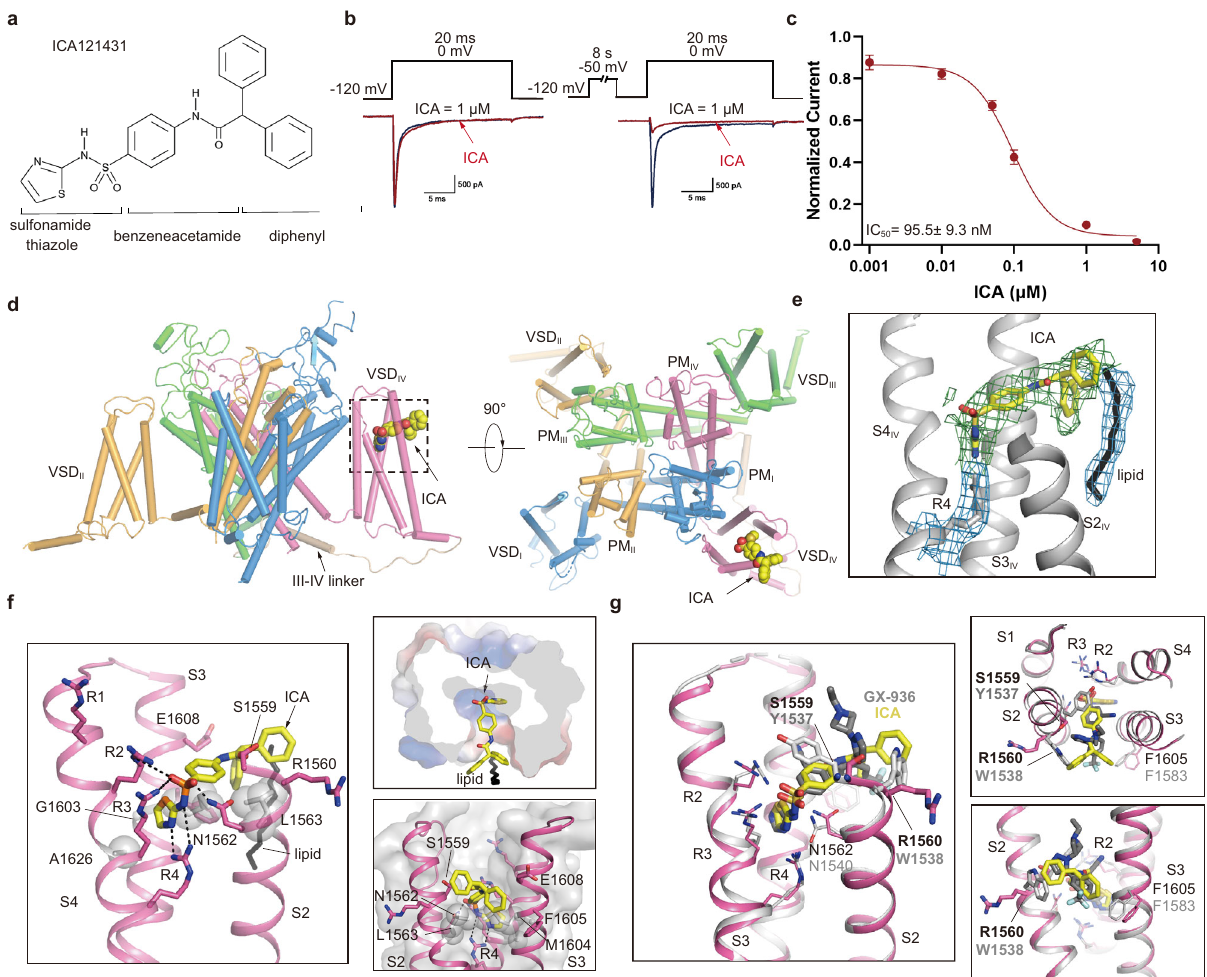
Fig. 4 Inhibition of Na V 1.3 by ICA and the binding site for ICA. a The chemical structure of ICA. b ICA preferentially inhibits Na V 1.3 at inactivated state. Current traces were recorded on Na V 1.3-transfected HEK293T cells, showing the effect of 1 μ M ICA (red line) on Na V 1.3 using a resting-state inhibition protocol containing a 20-ms voltage step to 0 mV from holding potential (HP) at − 120 mV (left panel), or an inactivated-state inhibition protocol composed of an 8-sec pre-pulse conditioning step at − 50 mV to inactivate roughly half channels and back to − 120 mV for 10-ms followed by a 20-ms test pulse at 0 mV from HP at − 120 mV (right panel). Similar data were acquired from 6 cells for each protocol. c Dose-response of ICA on human Na V 1.3 using the inactivated-state inhibition protocol as described in panel ( b ). The Boltzmann distribution was fi tted to each data of the normalized remaining peak current under different ICA concentrations, to yield IC 50 at 95.5 ± 9.3 nM. Data are mean + / − SEM acquired from 3 – 6 cells. d ICA binding site in Na V 1.3. The complex structure of Na V 1.3 is shown in side view (left panel) and top-down view (right panel), with ICA shown in a sphere model. The black dashed square indicates the area to be shown in panel ( f ). e Cryo-EM densities at 2.4 σ for ICA (green mesh), R4 and a potential lipid molecule (blue mesh). f Detailed binding site for ICA inside the VSD IV of Na V 1.3. Side chains of key residues interacting with ICA are shown in sticks. Black dashed lines indicate electrostatic interactions between ICA and VSD IV . g Comparison of binding sites for ICA in Na V 1.3 and GX-936 in Na V 1.7 (gray). Key residues determining isoform selectivity are labeled in black for Na V 1.3 and light gray for Na V 1.7, respectively. Source data are provided as a Source Data fi